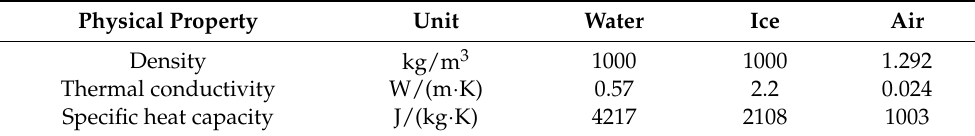
Figure 2. Dimensionless crust thickness vs. time for a droplet with a 2 mm diameter at T ∞ = − 20 ◦ C and T 0 = 3 ◦ C. Table 1. Physical properties of water, ice, and air used for the